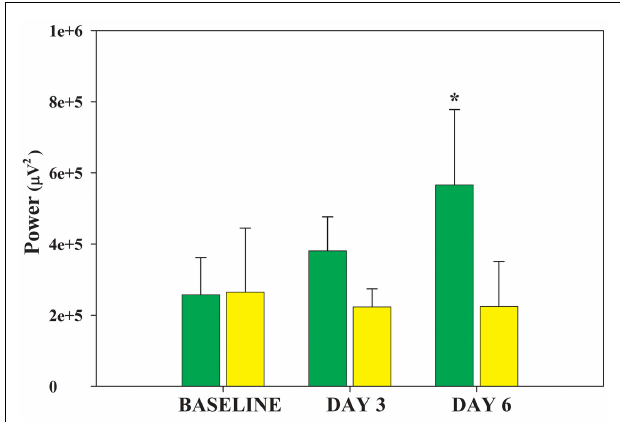
FIGURE 2 | Changes in ECoG delta power by group. Average delta power during 30 artifact-free, 4s periods of SWS is plotted for each group on the baseline day and shaker days 3 and 6.The DAY by GROUP interaction is significant ( F = 7.13, df = 2.10, p = 0.012).The RD group (green bars) successively increases delta power whereas theTXC group (yellow bars) first shows slightly decreased delta power that later levels off. Post hoc comparisons between the two groups do not reach statistical significance on any single day, but trended toward differences between each other on DAY 3 and DAY6 ( p = 0.051, p = 0.056, respectively; Bonferroni corrected post hoc t -tests).The rising delta power in the RD group’s SWS achieved significance in its difference from baseline on DAY6 ( ∗ p = 0.047).